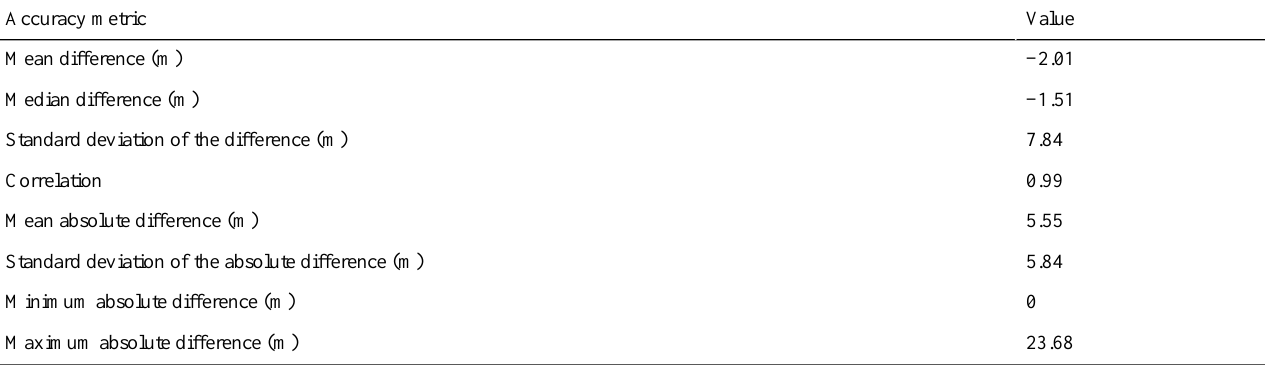
Table 2. Accuracy metrics for the indoor algorithm. By difference, we mean the difference between the estimated distance as computed by the app and the reference distance, as measured by the trundle wheel.